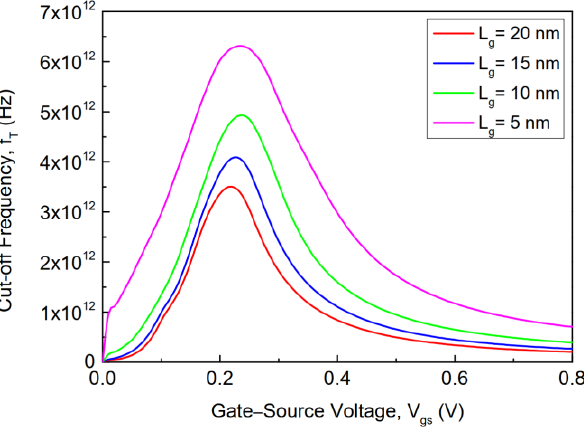
Figure 18. Cut-off frequency as a function of gate – source voltage with different gate lengths at V ds = 0.05 V.